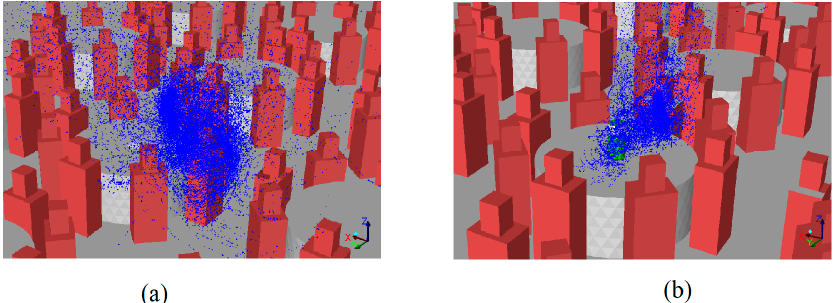
Figure 12. The dispersion processes of viral particles under two ventilation conditions: ( a ) CA-Ballroom; ( b ) CAT.